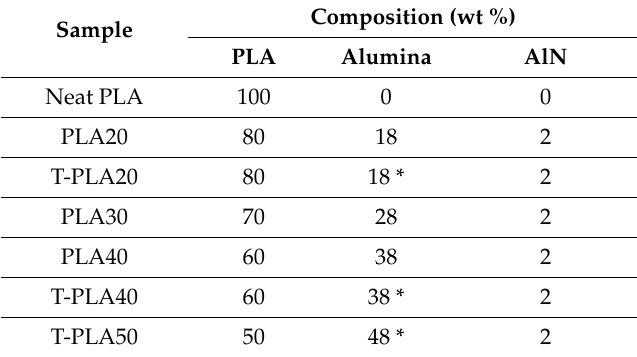
Table 1. Sample names and compositions of the composite